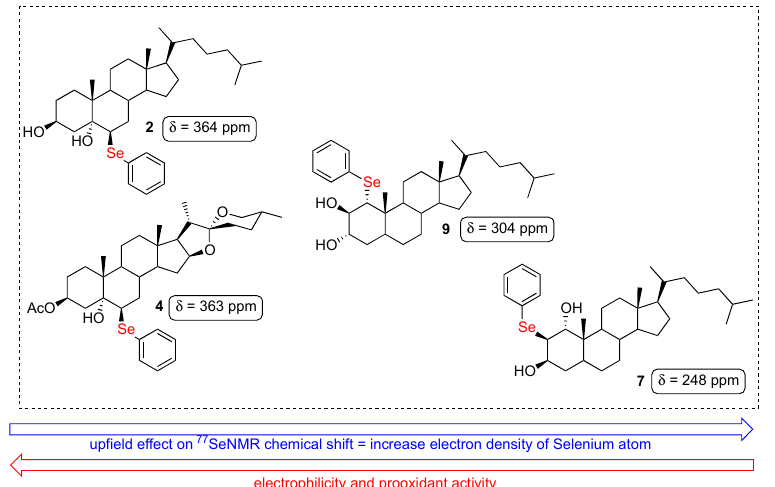
Figure 5. 77 SeNMR Chemical shift as parameter to predict biological aspects.